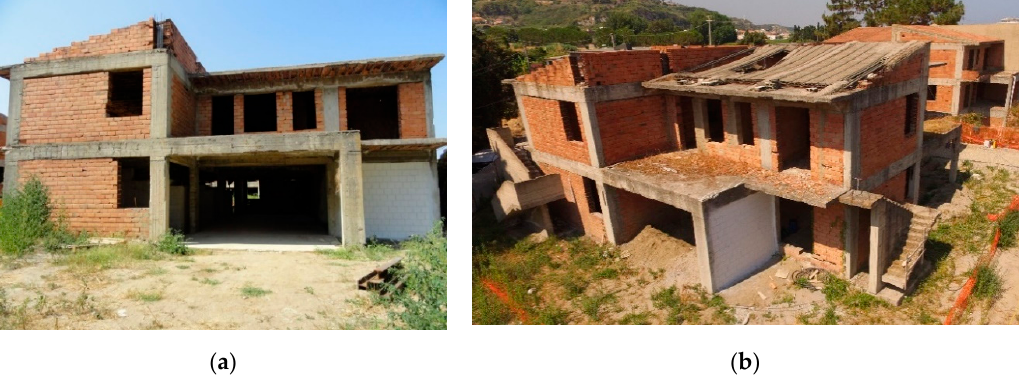
Figure 2. South ( a ) and north-west ( b ) building views.